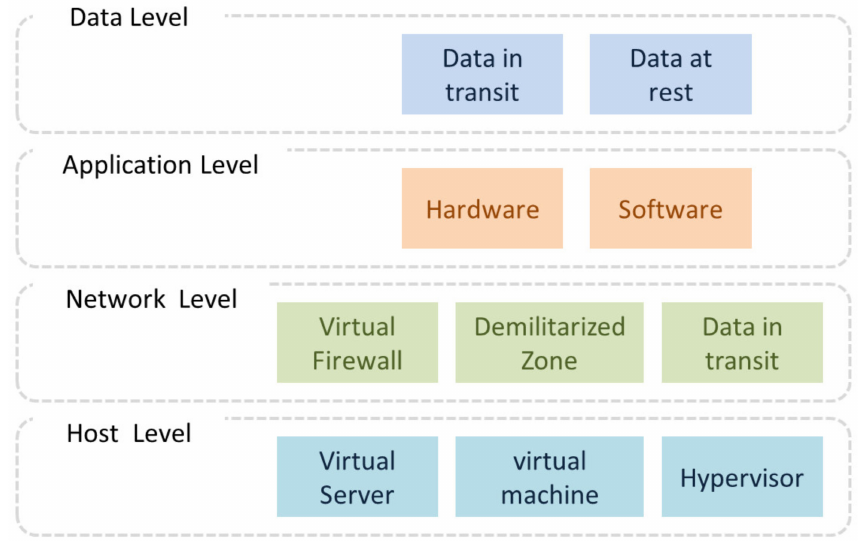
Figure 6. Cloud infrastructure